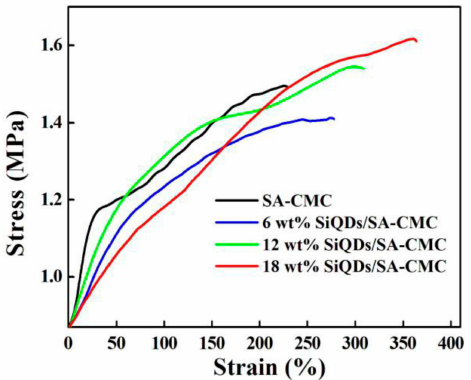
Figure 8. Strain–stress curves of pure SA-CMC and SiQDs / SA-CMC